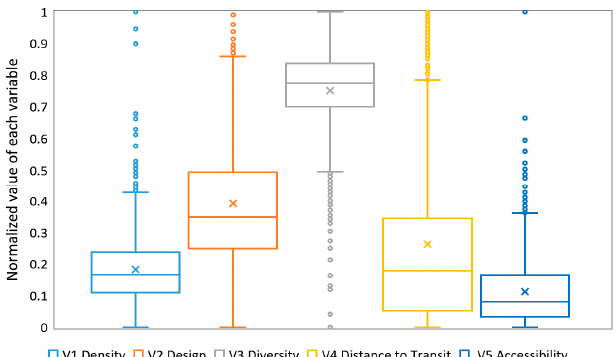
Figure 11. Box plots for density, design, diversity, distance to transit and accessibility values (normalized). The whiskers extend from the ends of the box to the minimum value and maximum value. Individual points with values exceed a distance of 1.5 times the inter-quartile range (IQR = Q3 − Q1) below Q1 or above Q3 are plotted with circles.